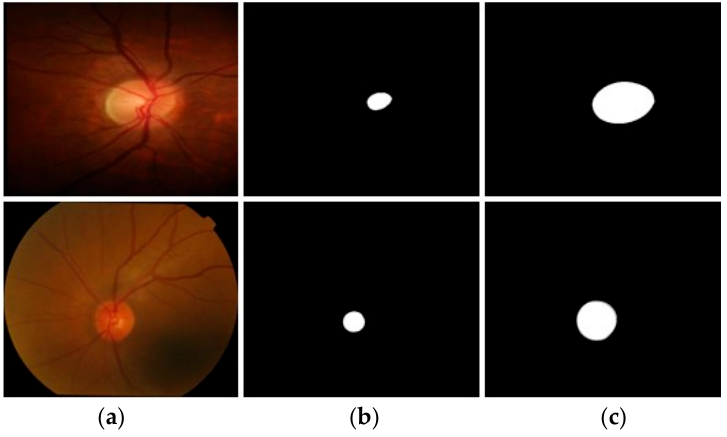
Figure 2. Sample images from row 1: Rim-One-r3; row 2: Drishti-GS databases. ( a ) Original image ( b ) groundtruth image with OD annotation ( c ) groundtruth image with the OC annotation.